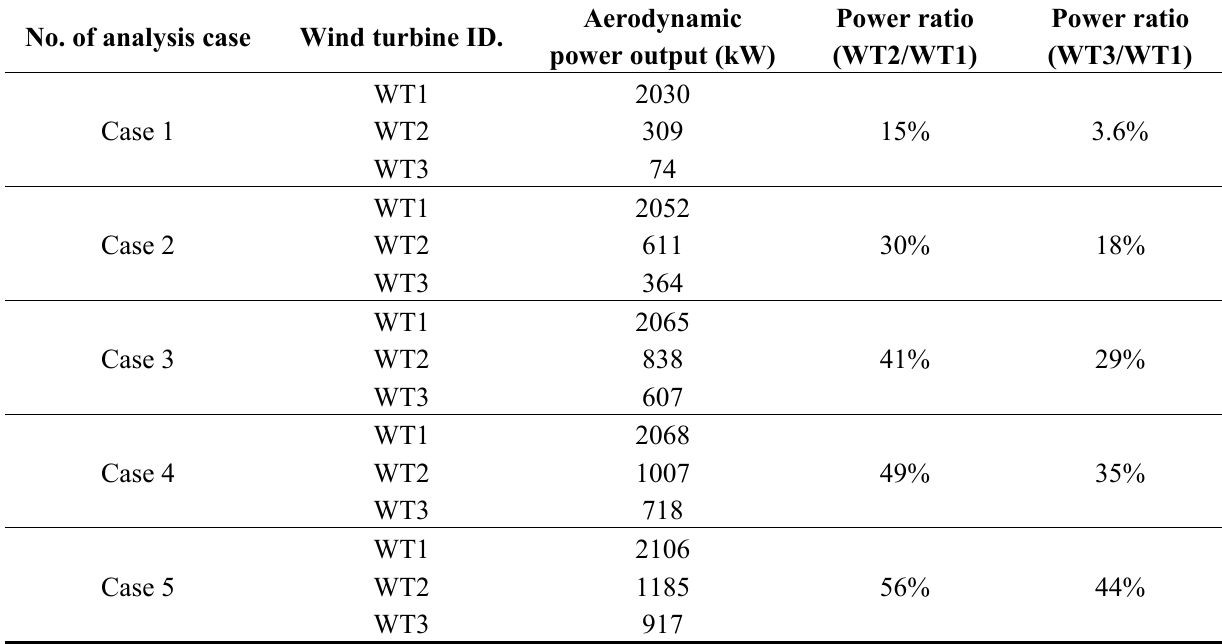
Table 4. CFD analysis results for 6 MW offshore wind farm.